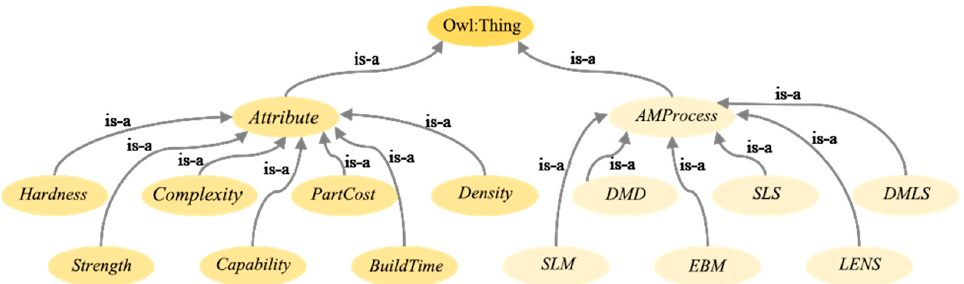
Figure 1. Graphical representation of fifteen top-level concepts in the DL ontology.